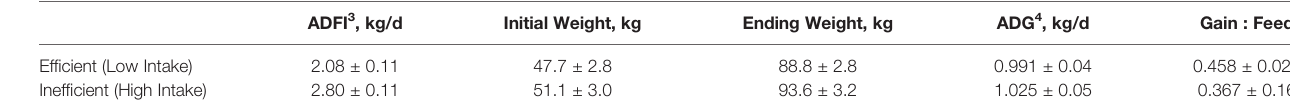
TABLE 1 | Descriptive data of ef fi cient and inef fi cient pigs (n = 30). 1,2